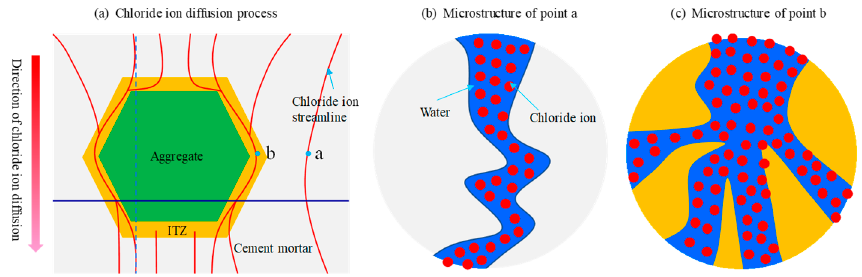
Figure 2. Chloride ion microscopic diffusion schematic diagram ( a – c ). (a) Chloride diffusion process, (b) Microstructure of point a, (c) Microstructure of point b, respectively.